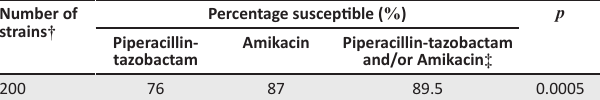
TABLE 3: Comparison of overall antibacterial coverage achieved by piperacillin- tazobactam alone versus piperacillin-tazobactam and amikacin. combined. Gram-negative organisms 2015–2018.